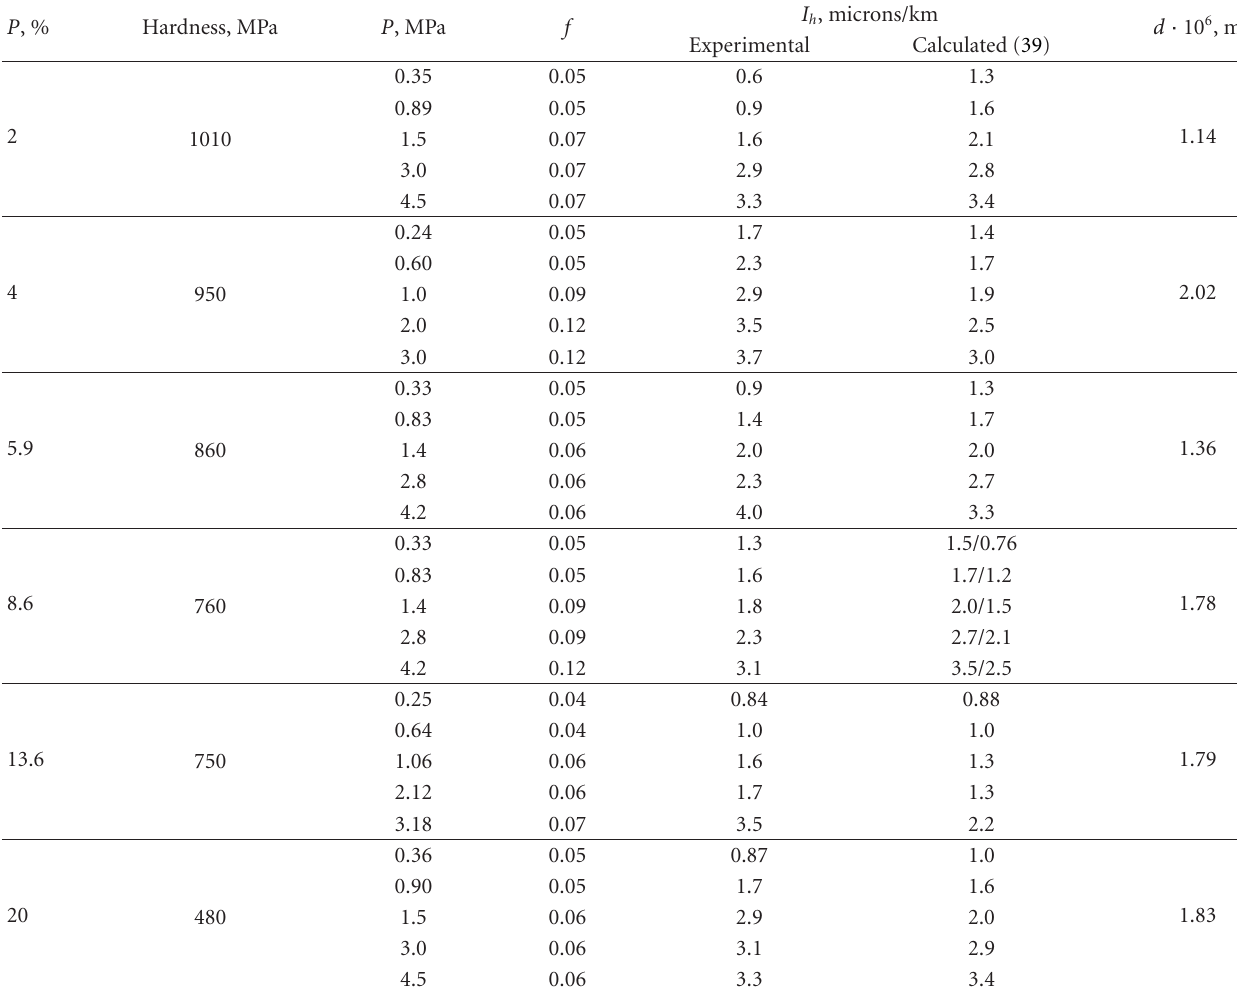
Table 5: Antifriction properties of iron under limited